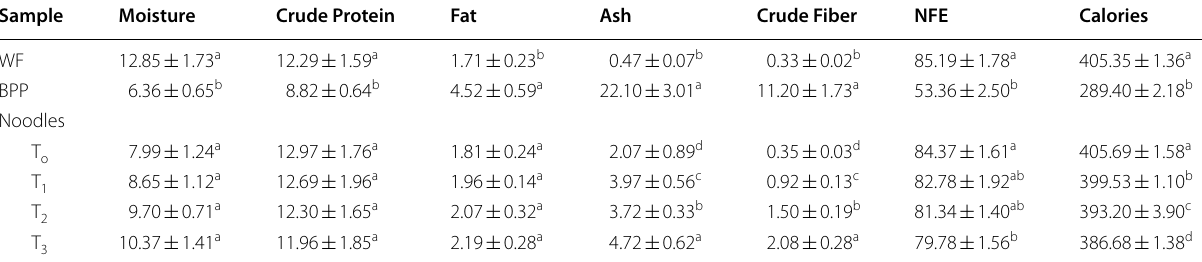
Values are means of triplicates HSD-Tukey Test T 0 0% BPP 100% WF; T 1 = +